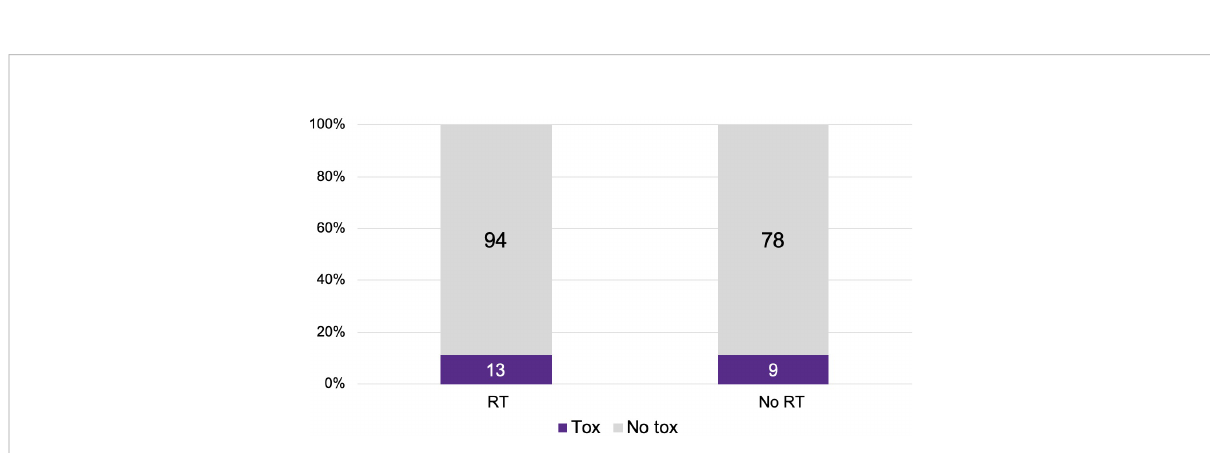
FIGURE 2 The plot of cardiotoxic events between the 107 patients who received thoracic RT versus 87 patients who did not receive thoracic RT. The numbers indicate patients who did (purple) or did not (gray) experience a cardiotoxic event. There was no signi fi cant difference in the percentage of patients with cardiotoxic events between the 2 groups (p=0.87).